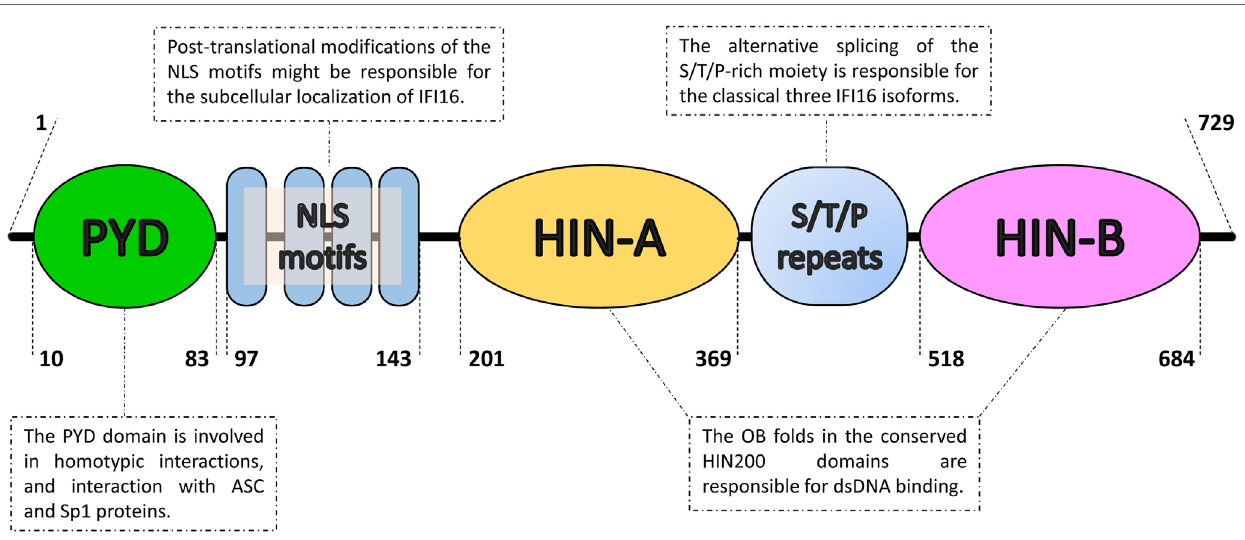
FigURe 1 | Domain organization of the IFN-inducible protein 16 (IFI16). From the N- to the C-terminal (left to right), IFI16 comprises a pyrin domain (PYD) involved in protein–protein interactions, a linker region containing four nuclear localization signal motifs (NLS) and two hematopoietic interferon-inducible nuclear protein with 200-amino-acid repeats (HIN200) domains, which is an hallmark of the absent in melanoma 2-like receptors/PYHIN proteins. The HIN200 domains include two tandem b-barrels, known as oligonucleotide–oligosaccharide-binding (OB) fold, which allow DNA docking in a non-sequence-specific manner. They are separated by serine/threonine/proline-rich (S/T/P) repeats, which are regulated by alternative mRNA splicing. The numbers represent the amino acid positions based on NCBI Reference Sequence